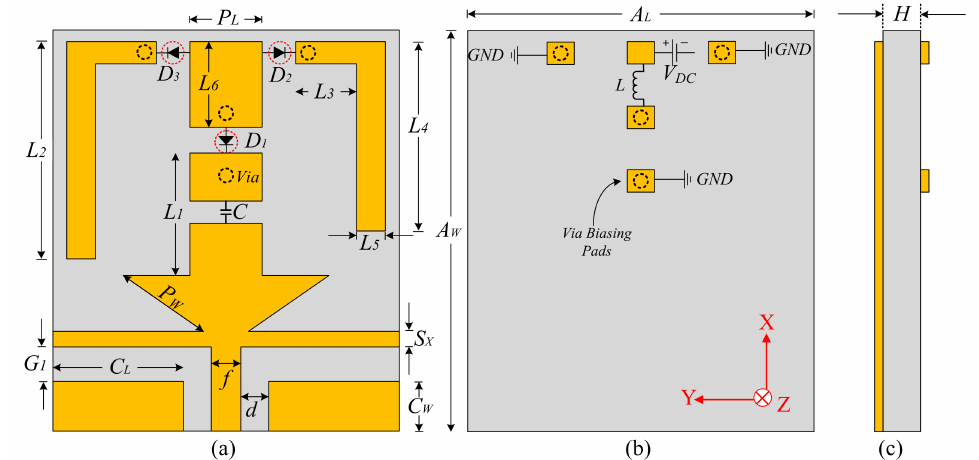
Figure 1. Geometrical configuration of the flexible and reconfigurable filtenna. ( a ) Top view. ( b ) Bottom view. ( c ) Side view.